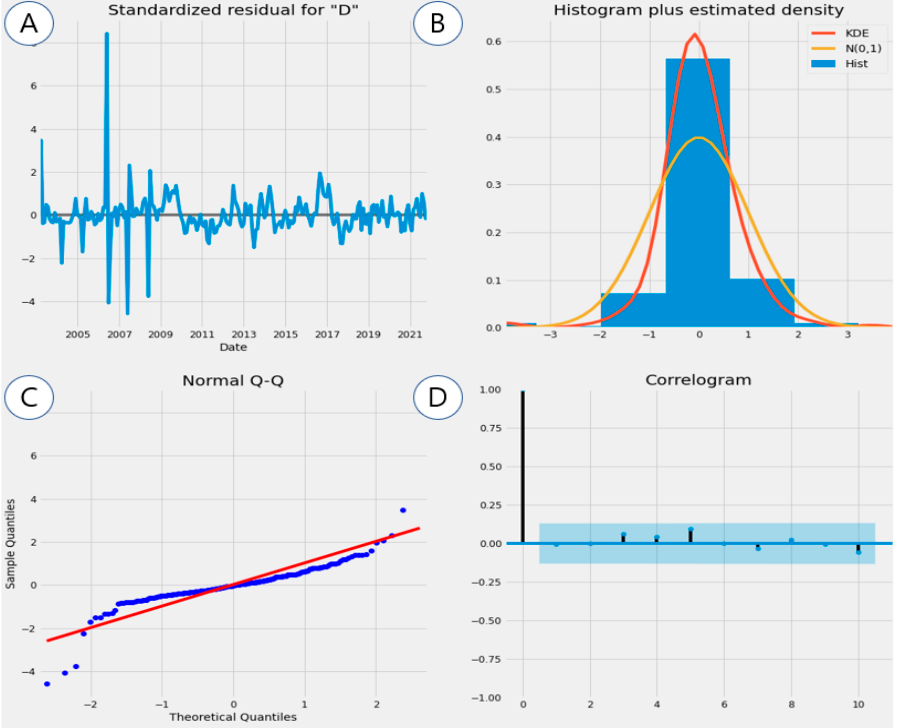
Figure 6. Cross-validation using an autocorrelation function, estimated density function, and quantile–quantile analysis. ( A ) Standardized residual was analyzed over 20 years, and downtime increased due to major component replacements between 2006 and 2007. ( B ) KDE (kernel density estimation) with a histogram in a normal distribution. ( C ) Verification for the normal distribution using a Q-Q analysis. ( D ) ACF shows that the stationary status was satisfied by gradually converging to zero in a correlogram.